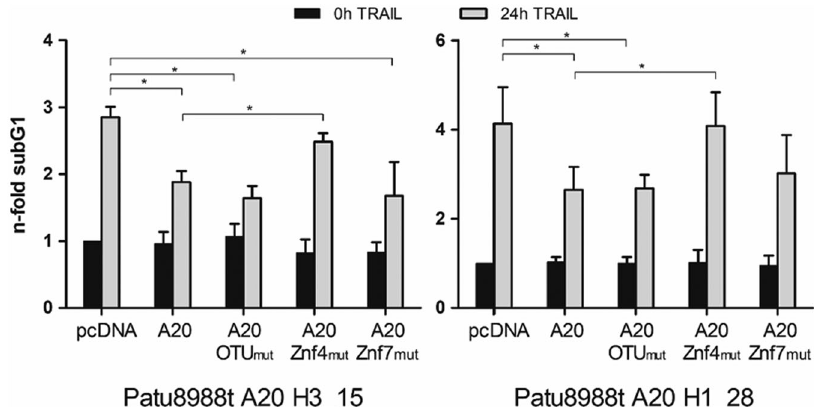
Fig. 6 Znf4 domain of A20 accountable for chemoresistance mediation. Patu A20cc cells were transfected with indicated A20 expression plasmids, treated with TRAIL for 24 h, and analyzed by subG1 assay. Plotted are mean ± S.D. from 5 independent experiments. Cell Death and Disease (2023)